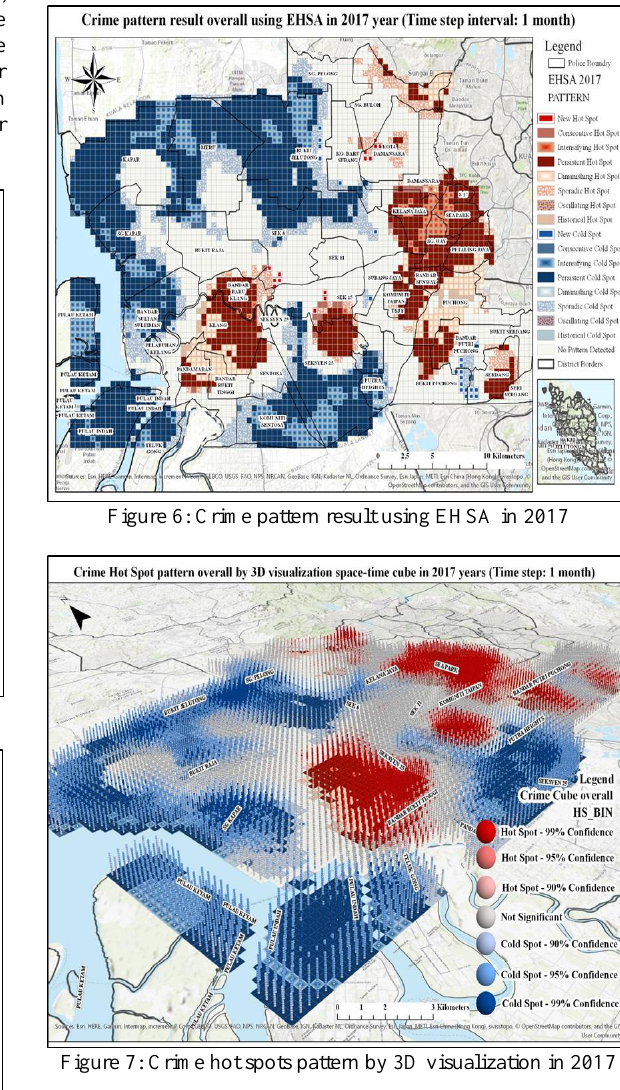
Figure 7: Crime hot spots pattern by 3D visualization in